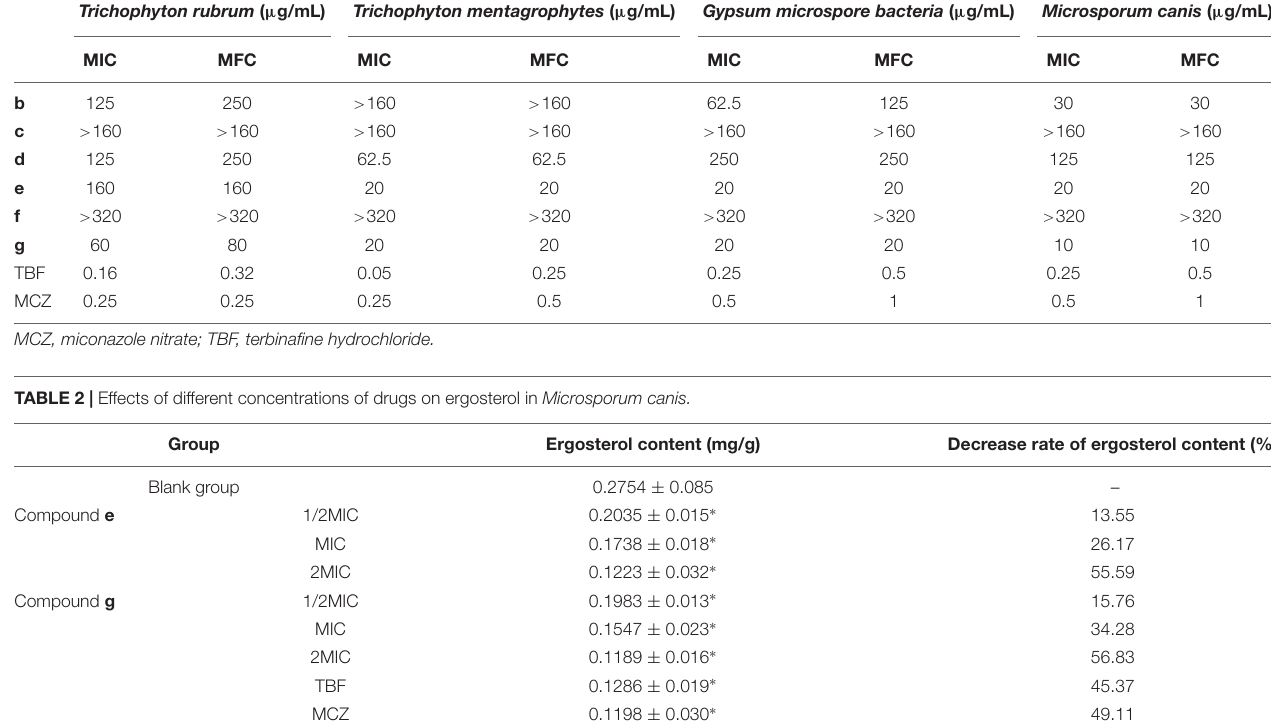
TABLE 1 | Minimal inhibitory concentrations (MICs) and MFCs of compounds against four dermatophytes. Trichophyton rubrum ( µ g/mL)